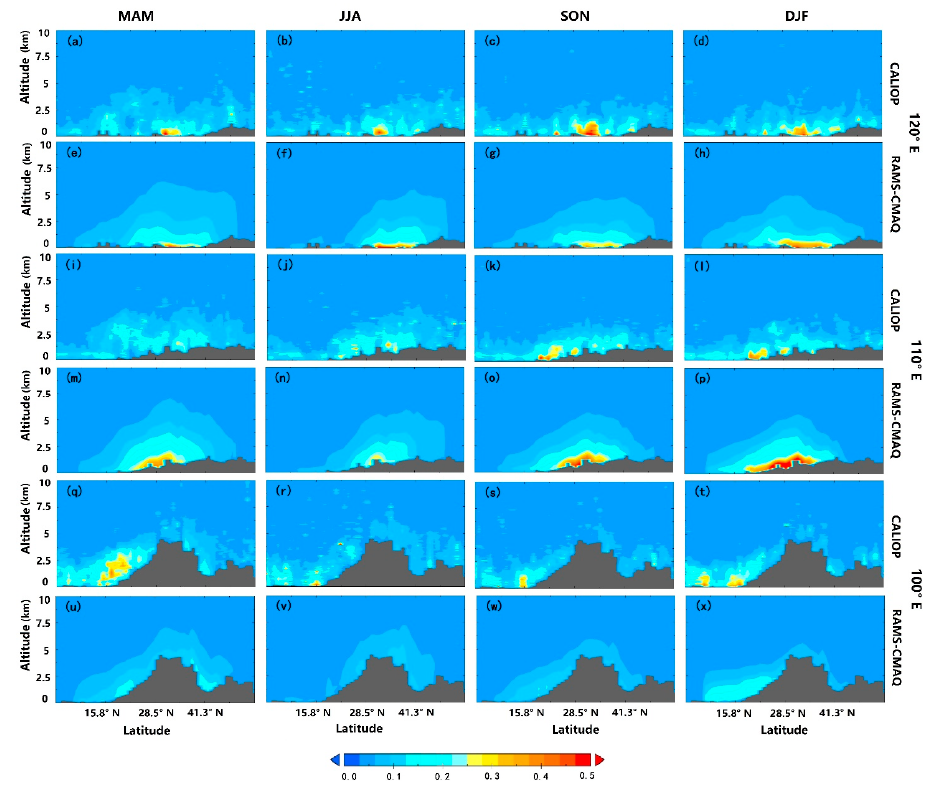
Figure 8. Cross sections of the seasonal mean AECs (unit: km − 1 ) along 120 ◦ E, 110 ◦ E and 100 ◦ E longitudes from CALIOP and RAMS-CMAQ